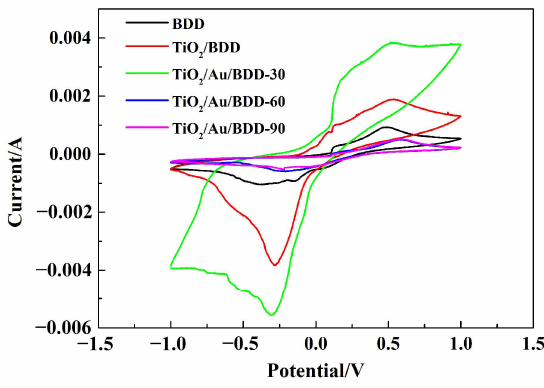
Figure 7. CV curves of the electrodes in 5 mM K 3 Fe(CN) 6 and 1 M KCl